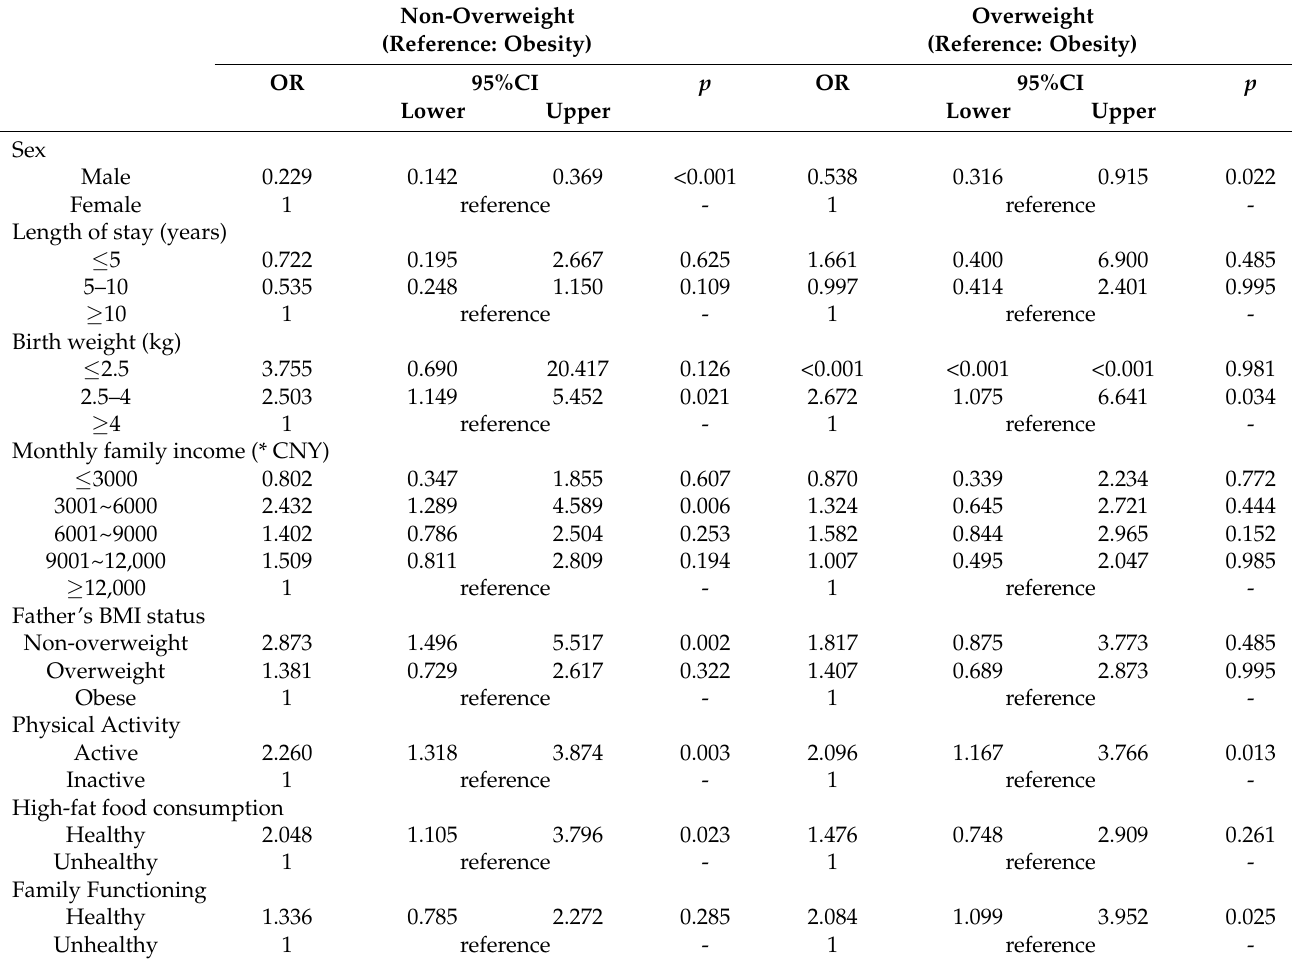
Table 3. Multinomial logistic regression analysis of BMI